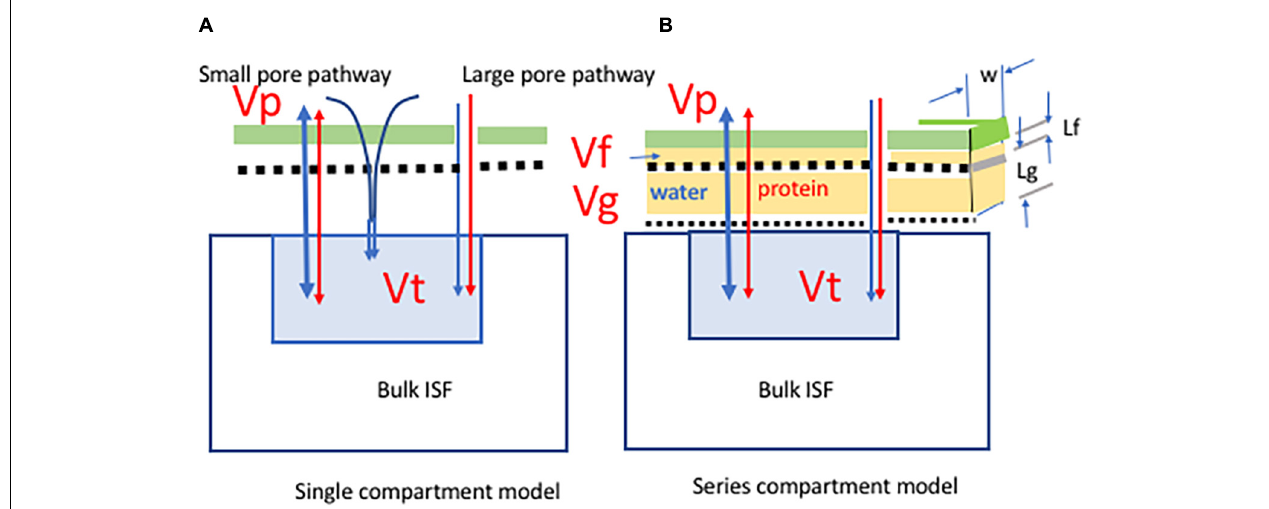
FIGURE 1 | Two models of water (blue) and protein (red) exchange from the plasma Vp to a sub-compartment of the interstitial fluid space Vt . In both models the restriction to movement of plasma proteins is determined by the fiber size and fiber spacing in the glycocalyx (green) and the glycocalyx is the primary barrier to the movement of protein from circulating plasma to the interstitial fluid. The fluid leaving the glycocalyx is funneled through breaks in the junction strands in the inter-endothelial cell junctions. A small number of large pores are in parallel with the glycocalyx-junction pathway. The colloid osmotic pressure difference determining water exchange is between the plasma and the fluid under the glycocalyx. The model on the panel (A) (single tissue compartment model) assumes the fluid leaving the glycocalyx mixes with a single tissue sub-compartment (volume Vt ) formed from a portion of the ISF that is in close proximity to microvessels. The model on the panel (B) (series compartment model) has two additional sub-compartments. Vf is within the inter-endothelial cell cleft and directly under the glycocalyx. Vg lies within the inter-endothelial junction and between the breaks in the junctional strands and the tissue sub-compartment. The volumes of these sub-compartments are determined from published details of the ultrastructure of the intercellular junctions and the position of the junction strand as indicated in panel (B) . In both models the PS product of the glycocalyx barrier is PdS1 and of the large pore pathway is PdS4. In the series compartment model PdS2 accounts for the barrier between Vf and Vg and PdS3 accounts for the barrier between Vg and Vt . Tables 1 , 2 describe the model parameters in